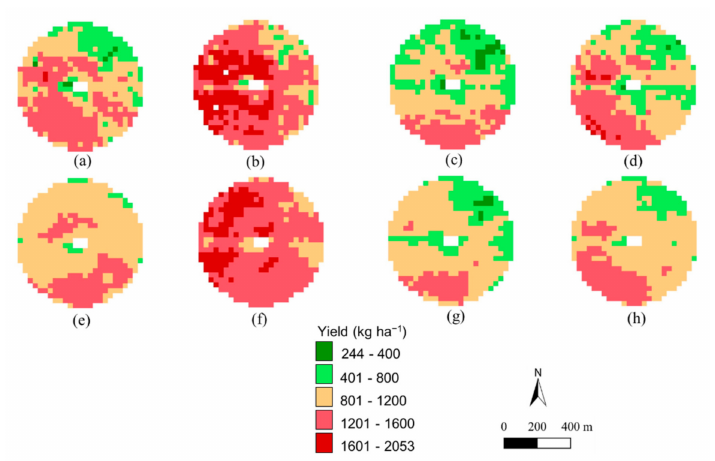
Figure A2. Geospatial variations in ( a – d ) observed and ( e – h ) simulated cotton lint yield at field #28, Halfway, Texas, USA, in ( a , e ) 2000, ( b , f ) 2001, ( c , g ) 2002, and ( d , h )